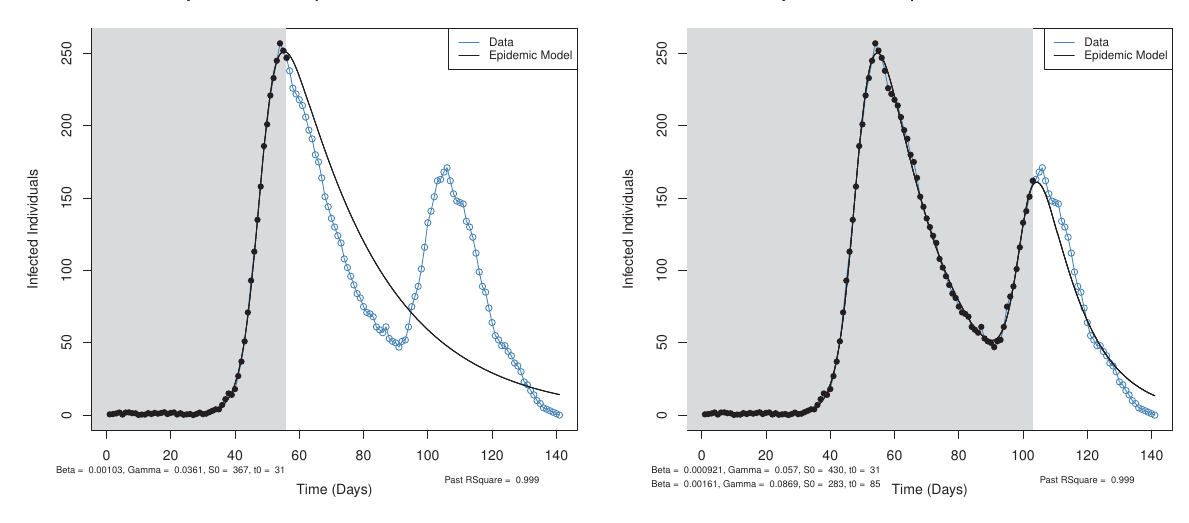
Figure 2: Synthedemic fit at days 56 and 103 to synthetic data with 2 subepidemics ( r 2 target = 0 . 99).